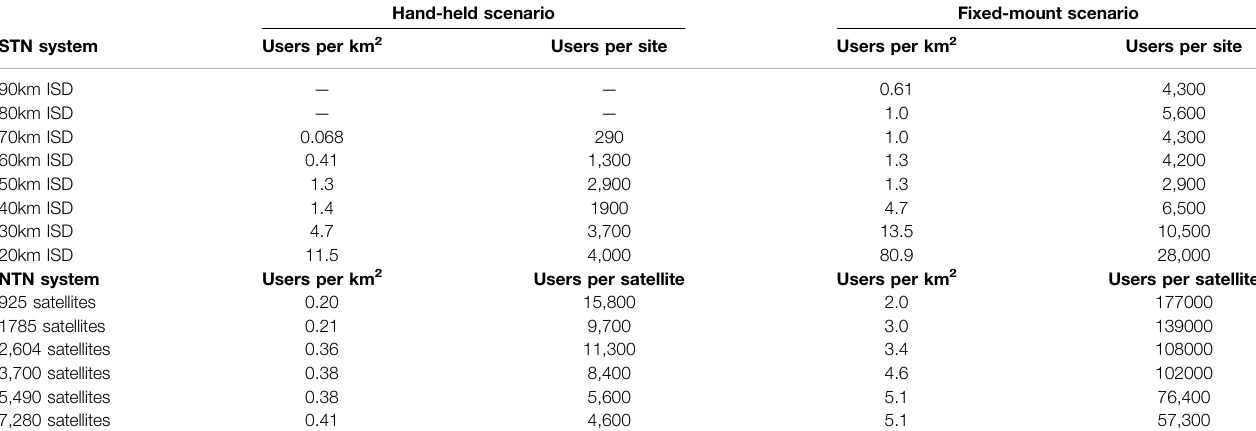
TABLE 4 | Maximum served users (de fi ned according to Traf fi c and Service Assumptions ) per area and per site or satellite ful fi lling UL and DL conditions.